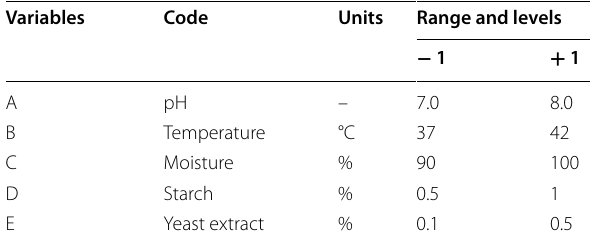
Table 1 Selected variables and their levels for 2 5 factorial design